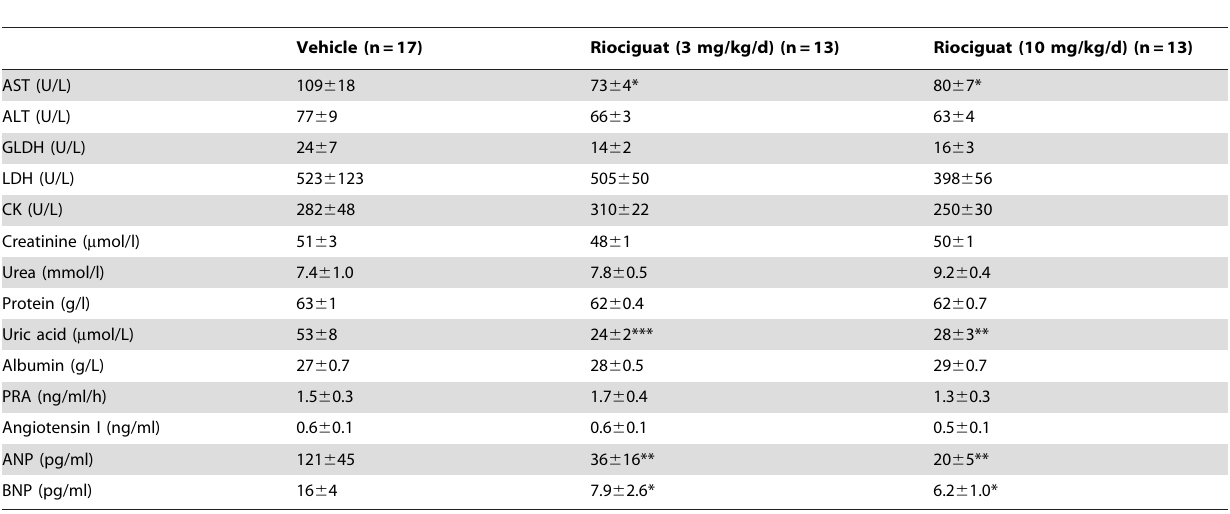
Table 3. Plasma biochemical measurements in the vehicle- and riociguat-treated Dahl/ss rats maintained on a high-salt diet.